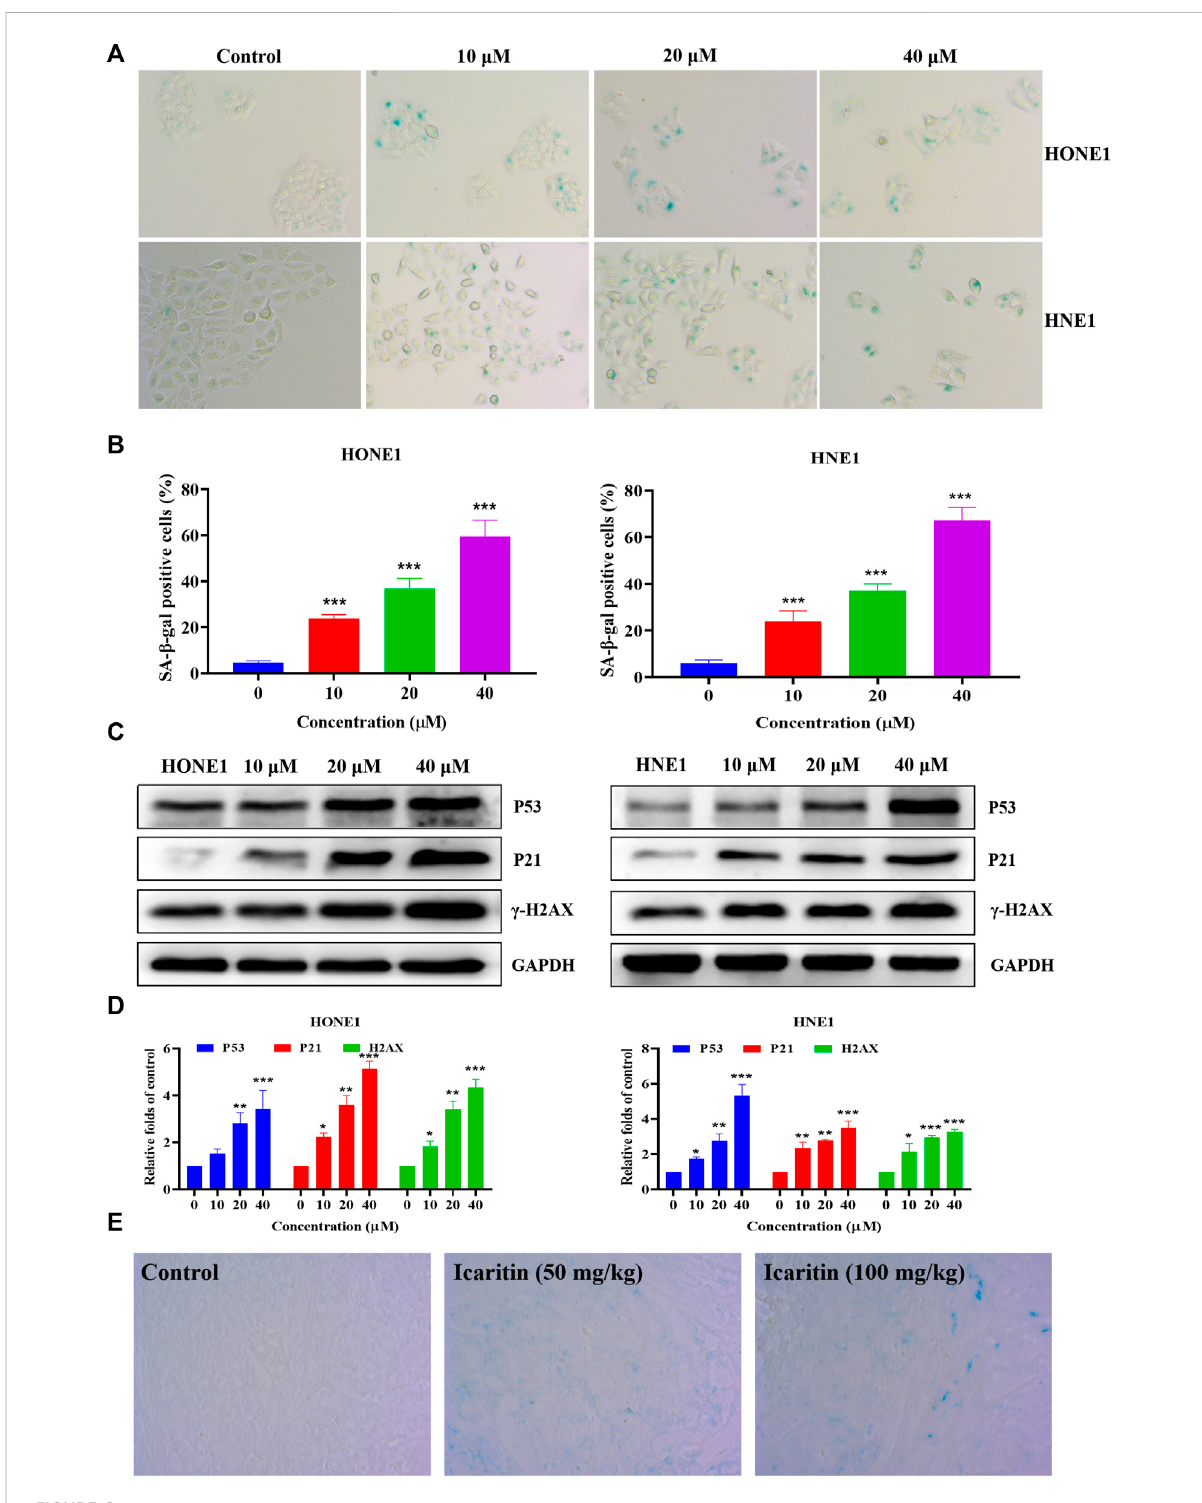
FIGURE 6 Icaritin induces senescence in the HONE1 and HNE1 cells. (A) Representative photomicrographs of SA- β -Gal staining in the control cells and icaritin-treated cells (10, 20, or 40 μ M) for 48 h. Scale bars, 10 μ m. (B) The percentage of SA- β -Gal positive cells. (C) The expression of the senescence-related protein in HONE1 and HNE1 cells was detected by western blotting after treatment with icaritin (10, 20, or 40 μ M) for 48 h. (D) The quantitative analysis ofproteinbands. (E) Representative photomicrographs ofSA- β -Galstaininginthecontrol and icaritin (50,100 mg/kg) groups. Scale bars, 10 μ m* p < 0.05, ** p < 0.01, *** p < 0.001 versus